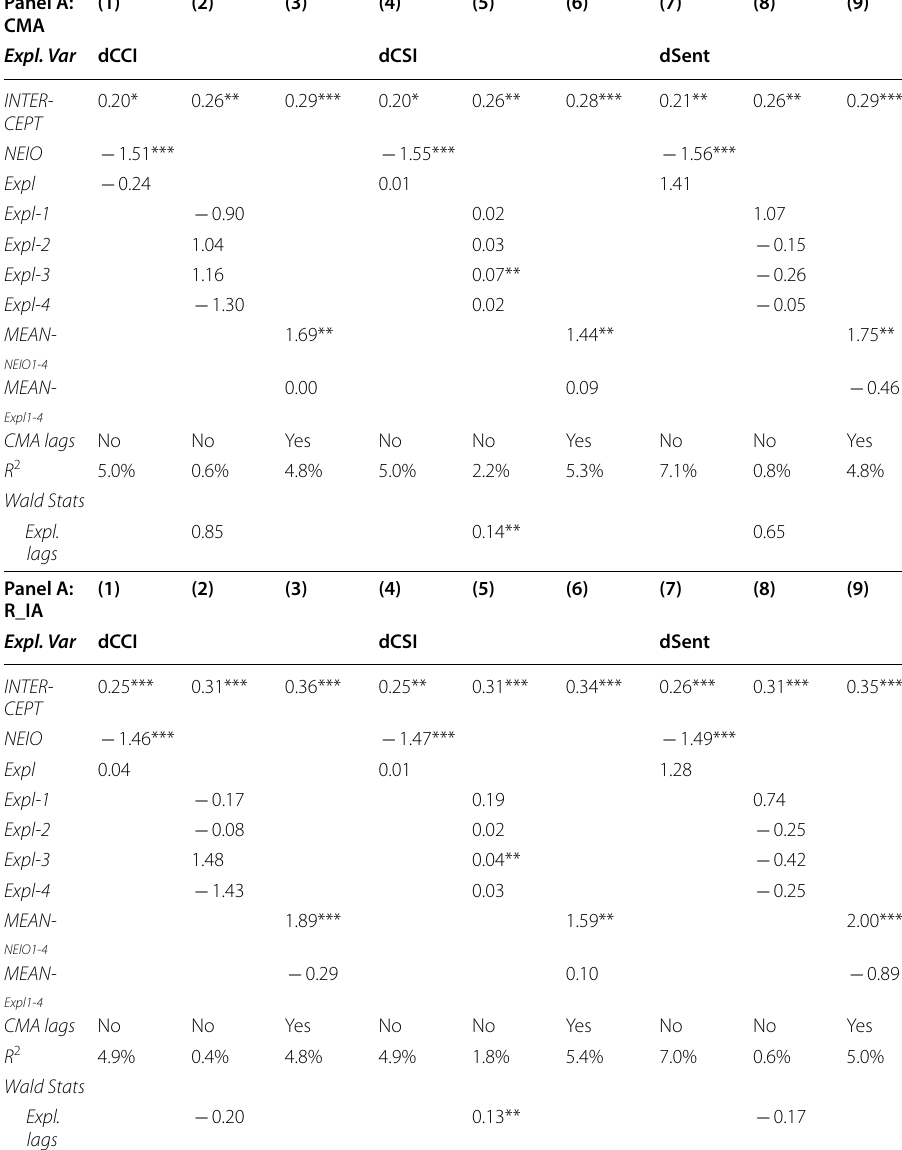
Table 4 Regressions of the investment factors on CCI, CSI and